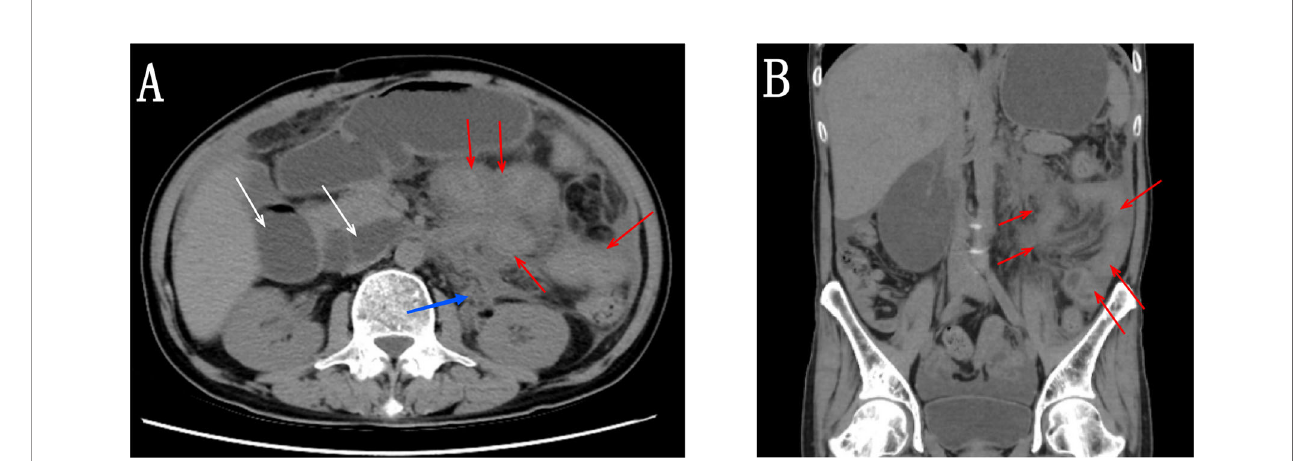
FIGURE 1 | (A, B) Abdominal CT scan showing multiple areas with thickening of the intestinal wall (red arrow), soft tissue in the left perinephric space along the medial aspect (blue arrow), and dilation of intestinal lumen (white